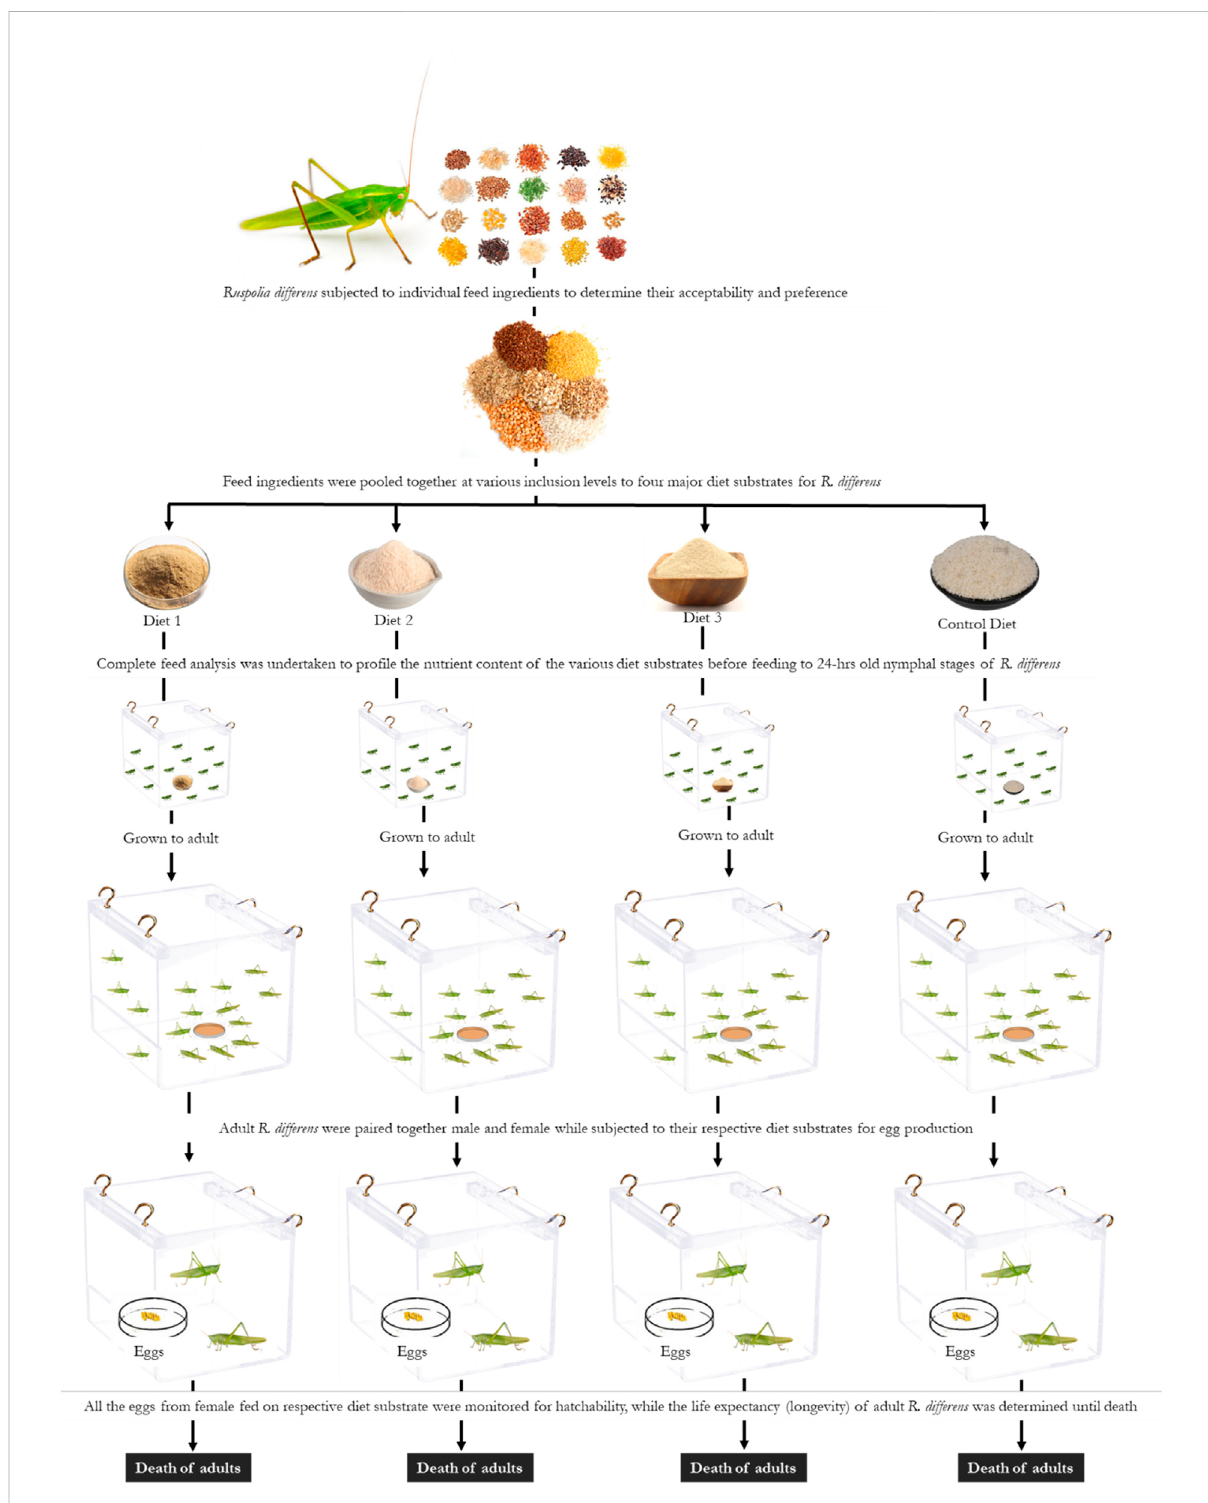
FIGURE 1 Schematic representation of the experimental set up of Ruspolia differens fed on four different diet substrates.